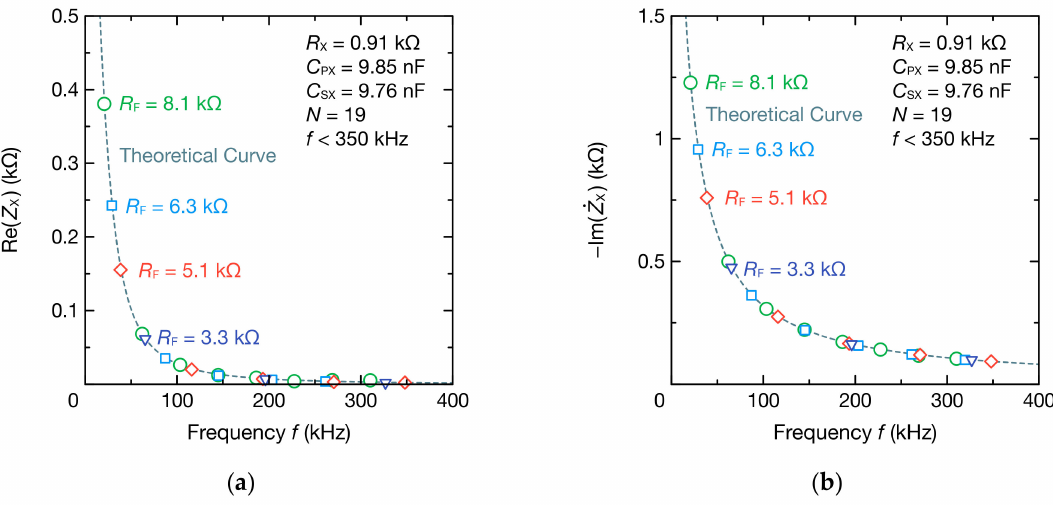
(cid:16) . (cid:17) Z X and ( b ) imaginary part Im